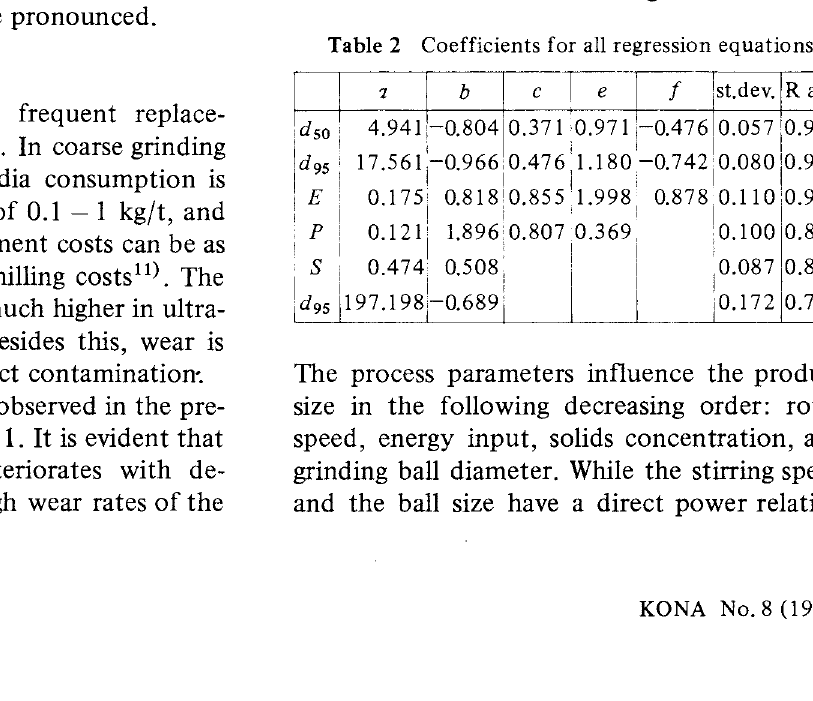
Table 2 Coefficients for all regression